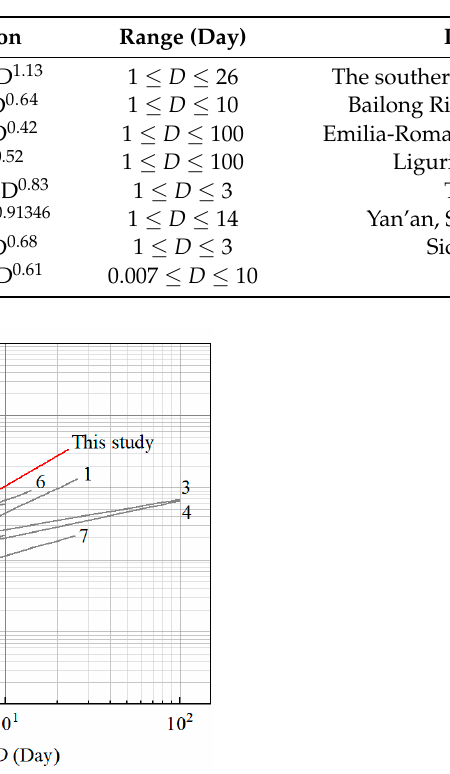
Table 3. Comparison of E–D rainfall thresholds for landslide occurrence in this study with rainfall thresholds in previous publications.